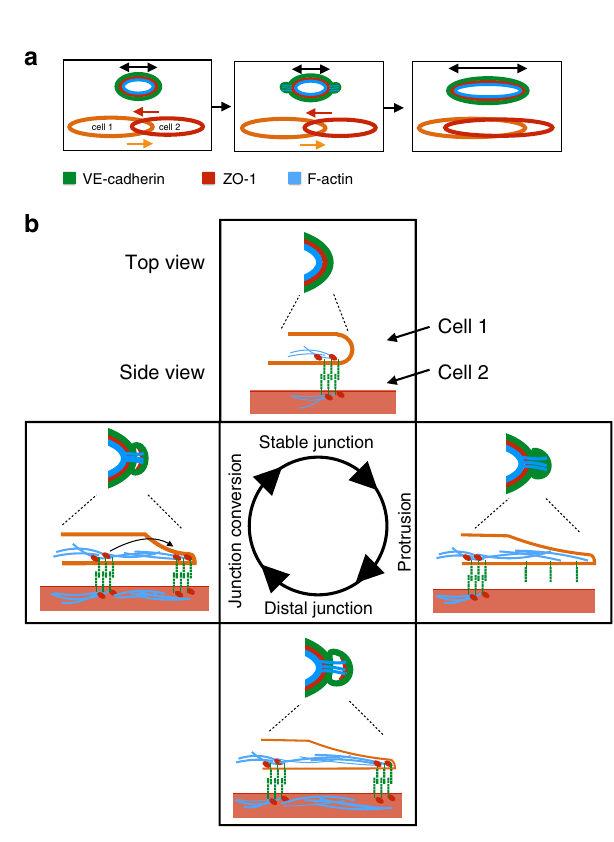
Fig. 8 A Ratchet-like molecular mechanism of junction remodeling. a Stepwise elongation of an endothelial cell junction during anastomosis. As two endothelial cells move over each other (bottom), the junction becomes elongated. The three proteins investigated in this study are indicated in different colors. b Proposed oscillatory mechanism of JBL function. A single cycle is depicted. F-actin protrusions emanate distally from a stable junction. These protrusions also contain diffuse VE-cadherin, but not ZO1. At the distal end of the protrusion, F-actin, ZO1 and VE-cadherin are components of a newly formed junction with VE-cadherin-mediated contact to the underlying cell. Eventually, dynamic F-actin remodeling pulls the proximal junction towards the new